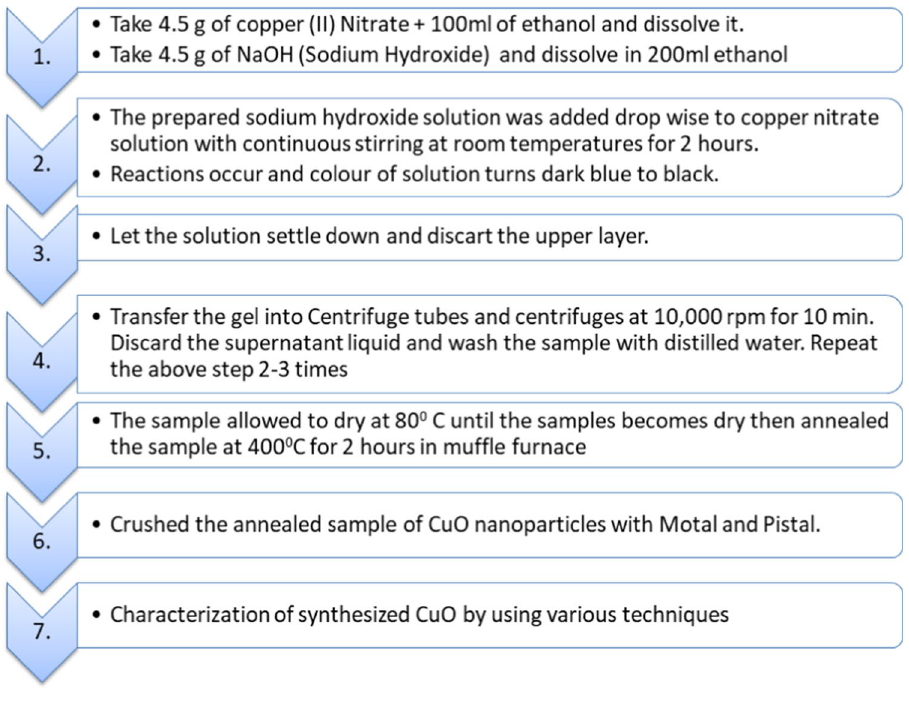
Fig. 1 Flow Diagram of syn- thesis of CuO nanoparticles by sol- gel